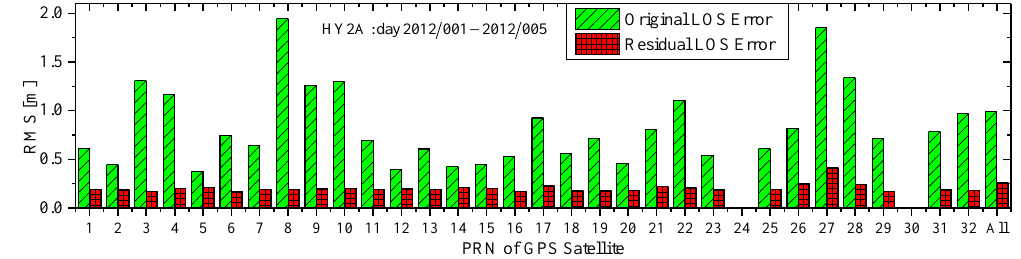
Figure 12. RMS comparison of original and residual LOS error.